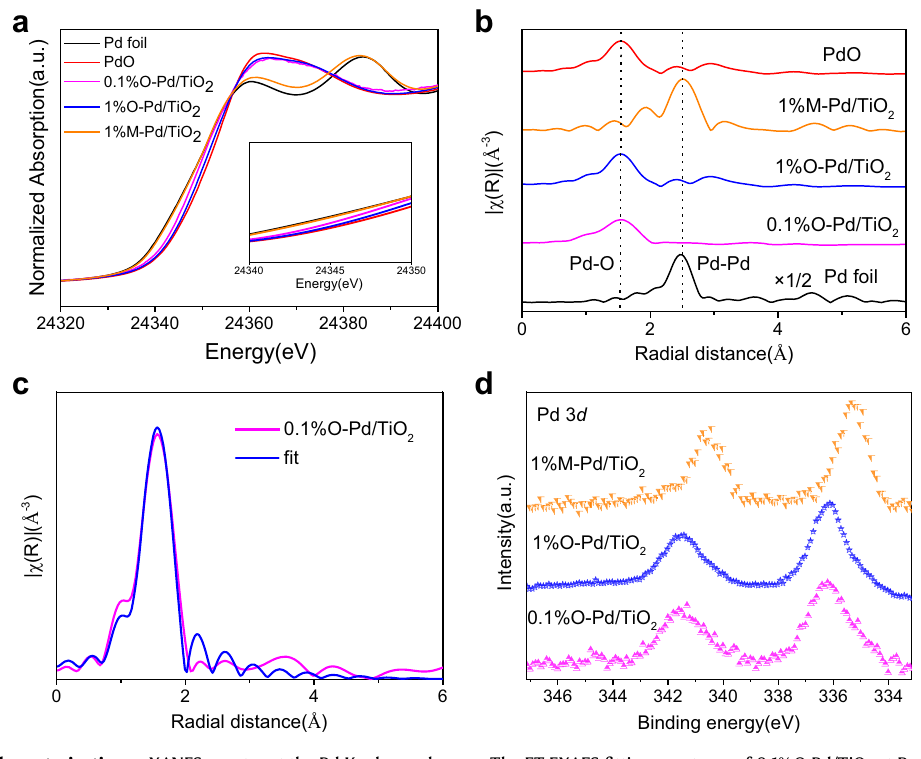
Fig. 3 | Spectroscopic characterization. a XANES spectra at the Pd K-edge and b TheFouriertransformsofPdK-edgeEXAFSspectraforcatalysts,PdO,andPdfoil.